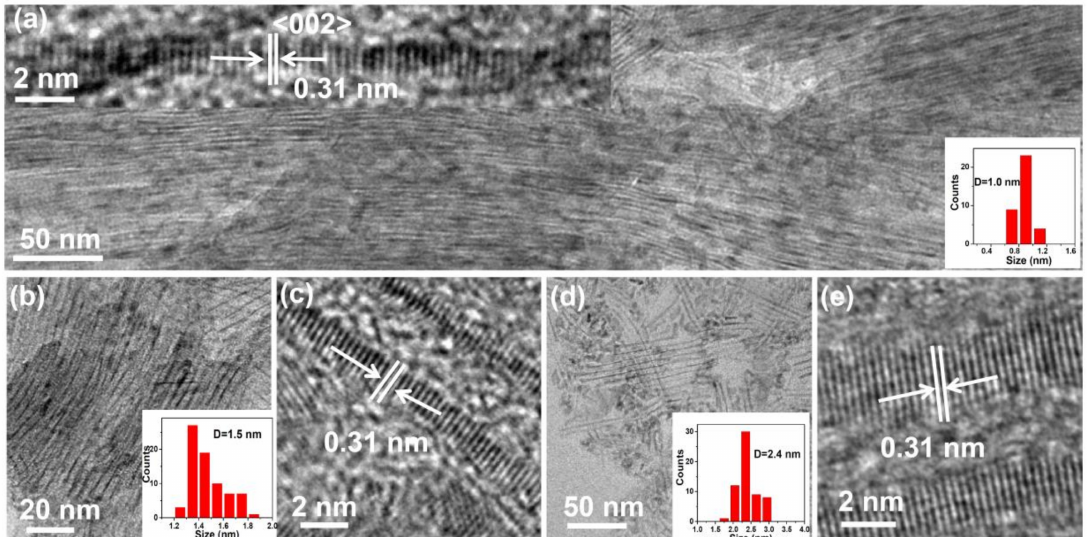
Figure 1. Representative TEM images of ultrathin ZnS nanowires with distinct diameters prepared by thermolysis of different amounts of Zn(exan) 2 in a hexadecylamine solution (ca. 6.0 mL) at 120 ◦ C for different periods of time: ( a ) 0.4 g of Zn(exan) 2 and reaction for 3.0 h; ( b ) 0.5 g of Zn(exan) 2 and reaction for 3.0 h; ( d ) 0.625 g of Zn(exan) 2 and reaction for 10 h. The insets in ( a ) are its corresponding HRTEM image and the diameter distribution histogram; ( c ) and ( e ) are the HRTEM images corresponding to ( b ) and ( d ),